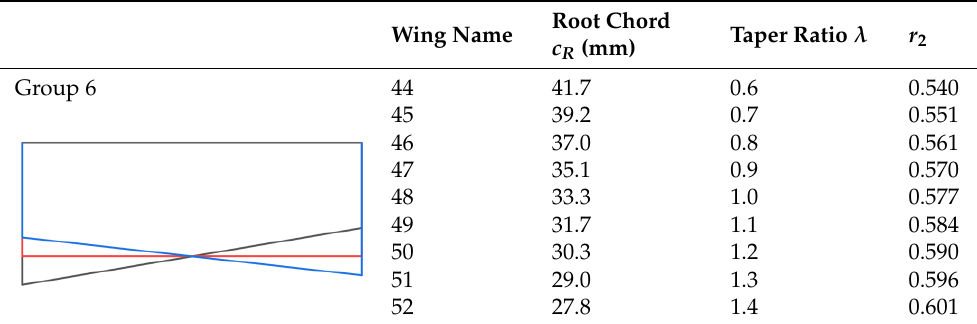
Table 3. Wings with different r 2 by changing the taper ratio λ .